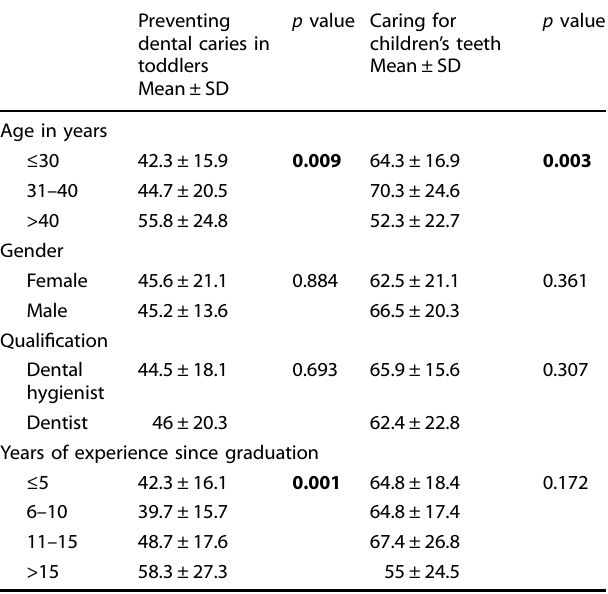
Table 4. Relationship between demographic characteristics and knowledge score of preventing dental caries in toddlers and knowledge score of caring for children ’ s teeth. Preventing dental caries in